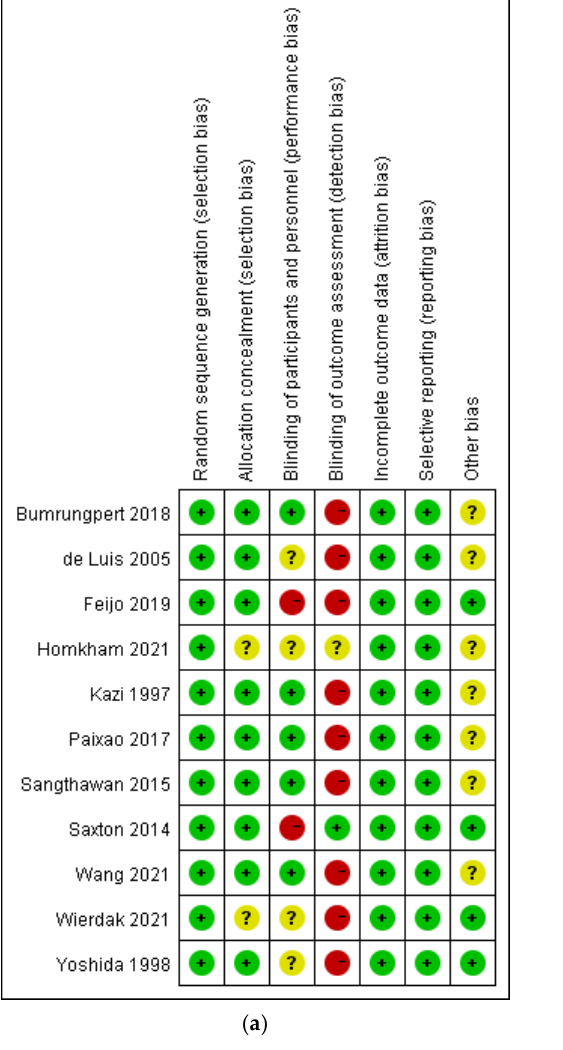
Figure 3. The result of the risk of bias assessment. ( a ) Risk of bias summary [48 – 58]; ( b ) risk of bias graph.